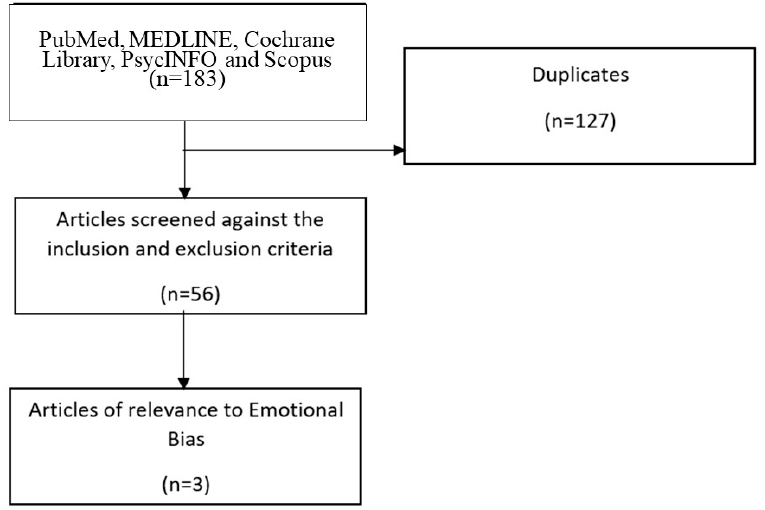
Figure 1. Selection of the studies.